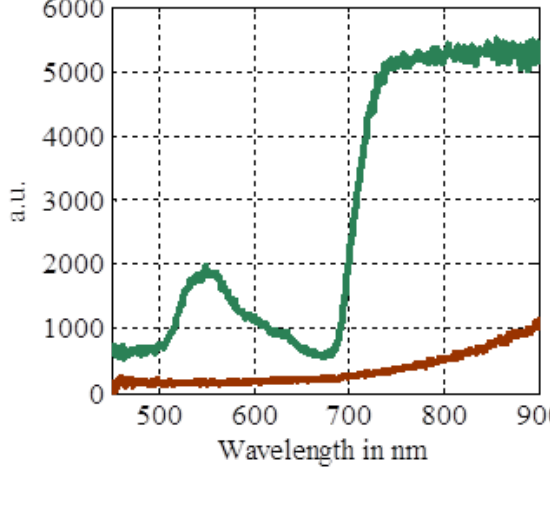
Figure 1. Reflectance spectral response from Arabidopsis (green) and organic garden soil (brown) (measured July